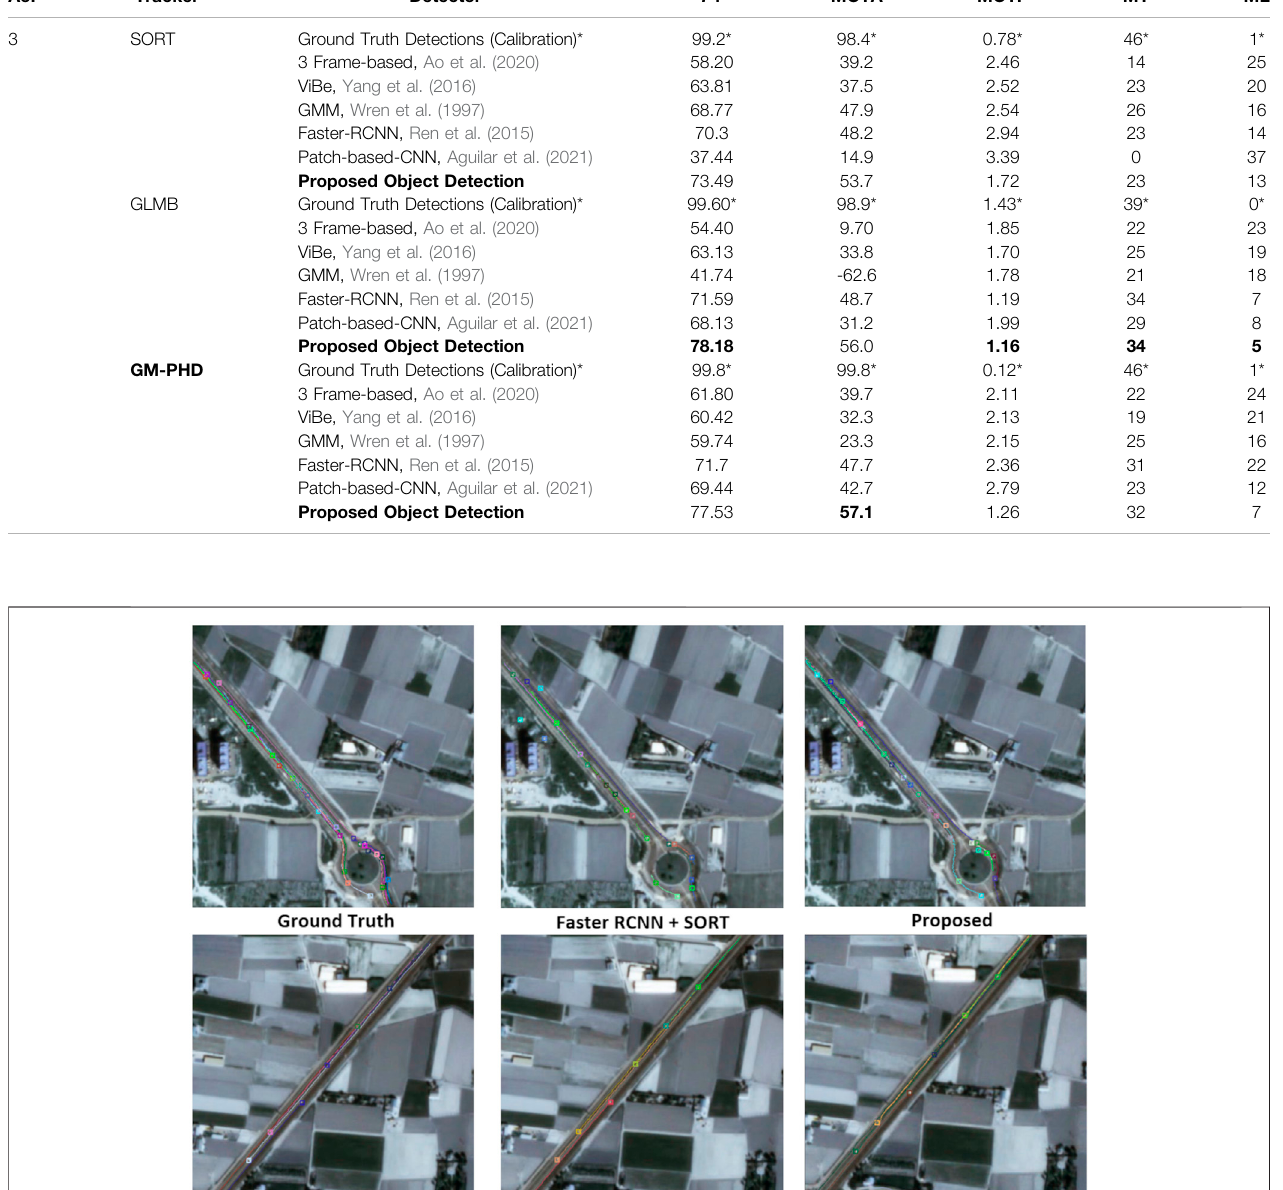
Frontiers in Signal Processing |